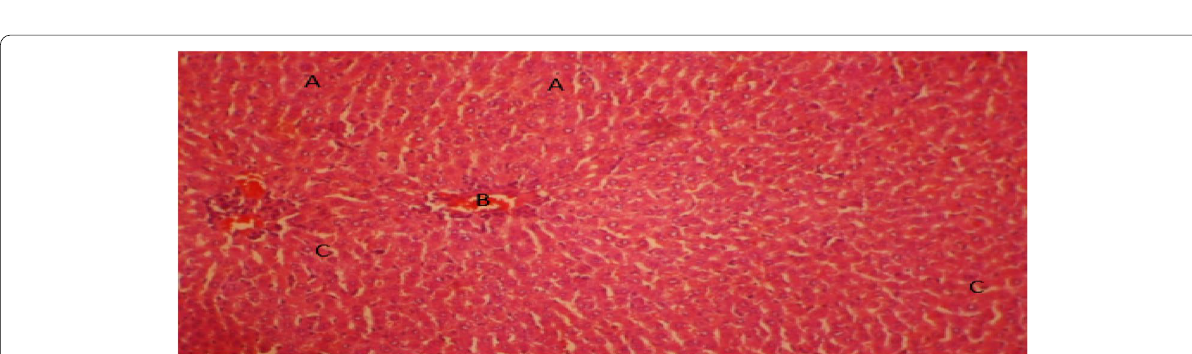
Fig. 11 Liver section of rat given 100mg/kg leaf extract only for 14 days (Group 9) showing: A , normal hepatocytes, B , portal vein and C , moderate Kupffer cell activation (H&E x 100)